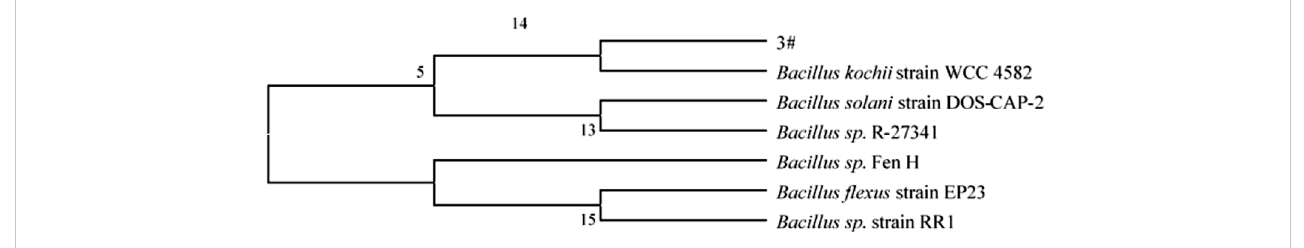
FIGURE 3 Phylogenetic tree of B. kochii 3#.